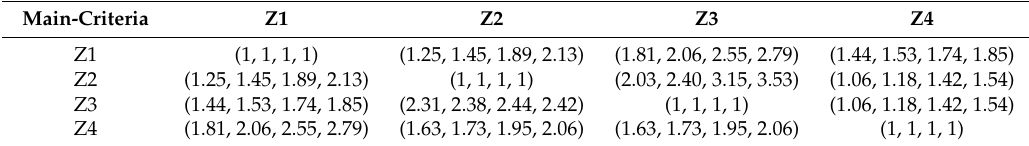
Table 7. Integrated fuzzy comparison matrix for main-criteria weights.